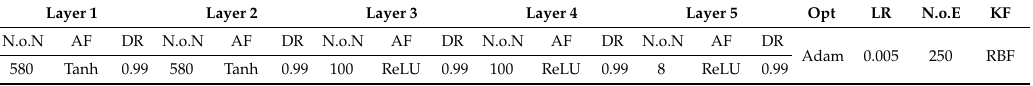
Table 6. The structures of the fitted DKL model for predicting multi-ion